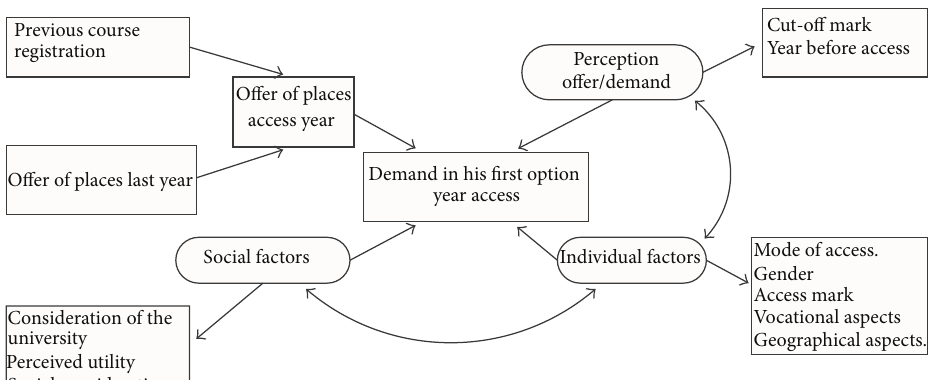
Figure 1: Diagram of the proposed structural model.